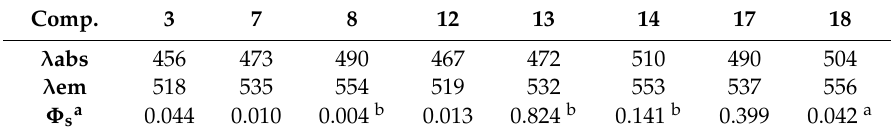
Table 1. Quantum Yields of Synthesized Reduced Xanthene Fluorophores.